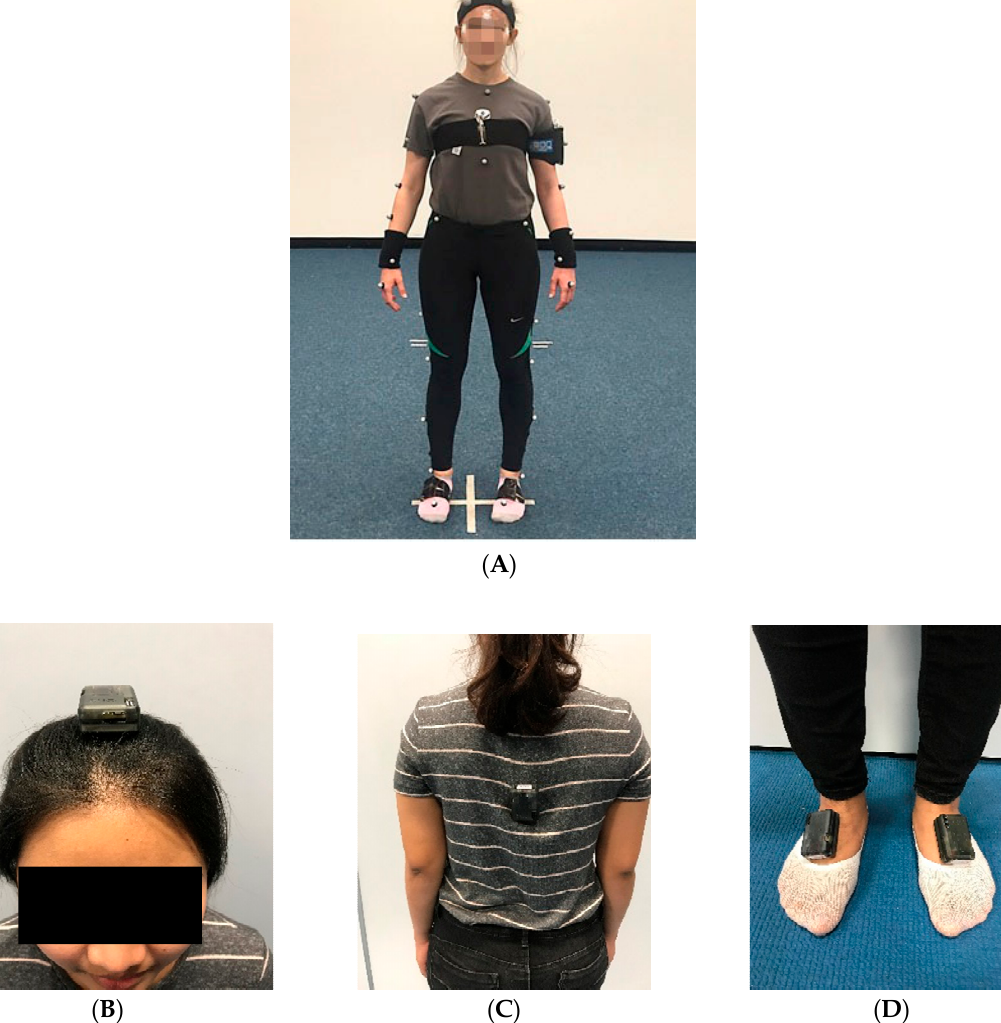
Figure 1. ( A ) Markers and inertial measurement units (IMUs) attached to the participant ( B – D ) IMUs attached to separate segments.